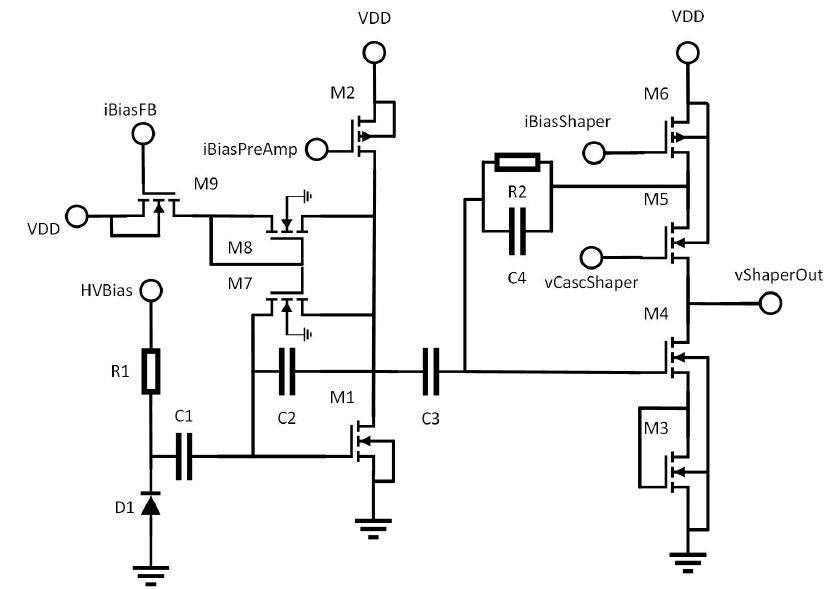
Figure 4. Schematic of the pixel front